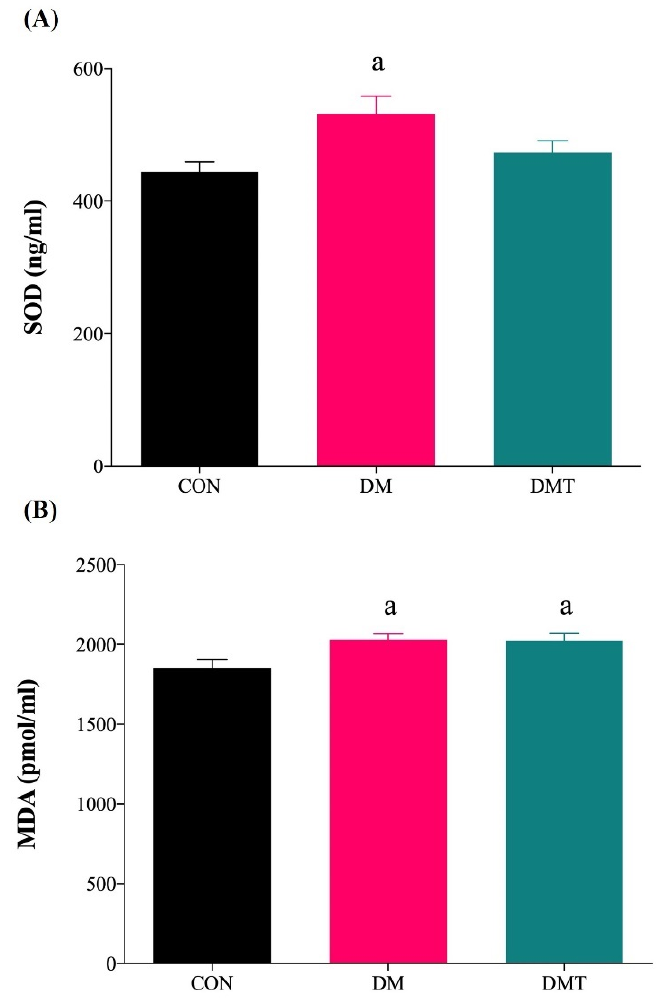
Figure 5. ( A ) SOD activity and ( B ) MDA level in the aorta of experimental rats (n = 9). a p < 0.05 vs. CON. Abbreviation: CON; Control, DM; Diabetes, DMT; Diabetes receiving TUDCA, SOD; Superoxide dismutase, and MDA; Malondialdehyde.